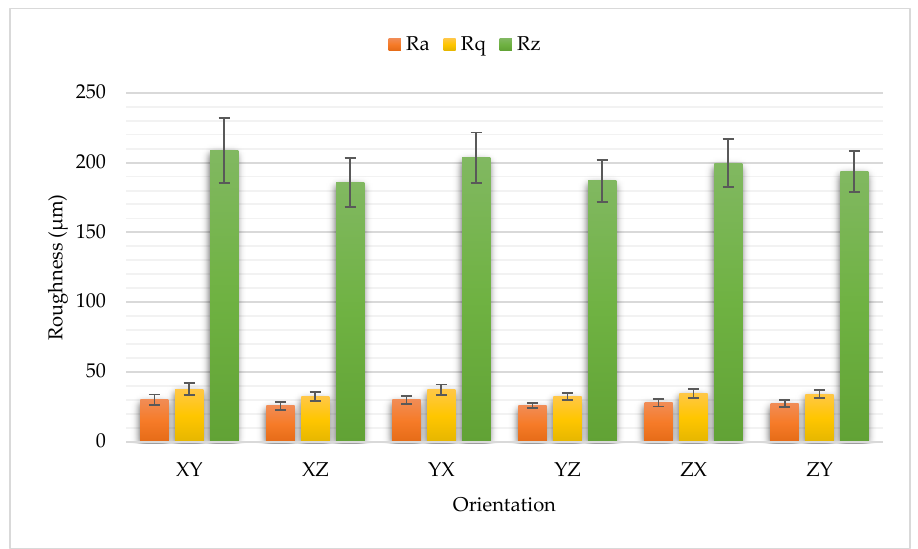
Figure 14. The average roughness and standard deviation of the thermoplastic polyurethane (TPU) samples grouped by orientation.